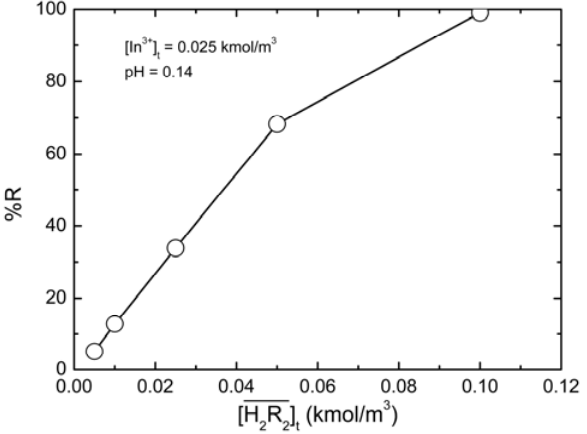
equilibrium with various D2EHPA concentrations in kerosene at 25  C. 3+ pH =